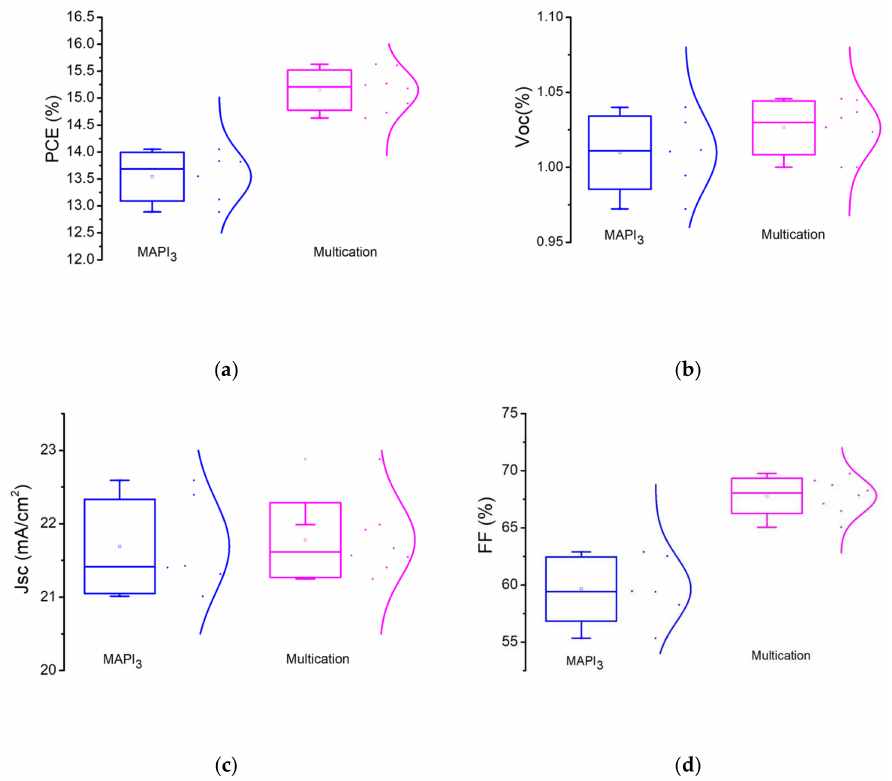
Figure 6. Statistical photovoltaic parameters of the of MAPbI 3 perovskite vs. multication perovskite: ( a ) PCE; ( b ) V OC ; ( c ) J SC ; ( d ) Fill